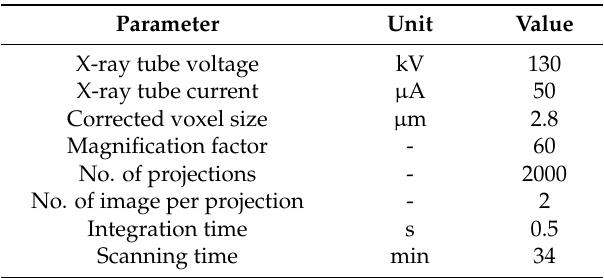
Table 3. Overview of the scanning parameters used in this work.